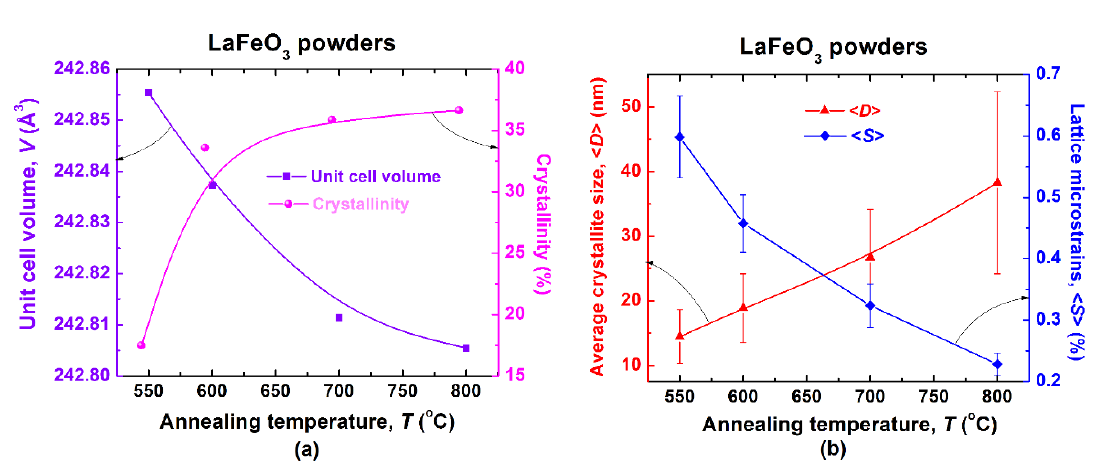
Figure 4. Annealing temperature dependence of: ( a ) unit cell volume and crystallinity and ( b ) average crystallite size and lattice microstrains. Table 1. Rietveld refined structural parameters for LaFeO 3 powders annealed at various temperatures.